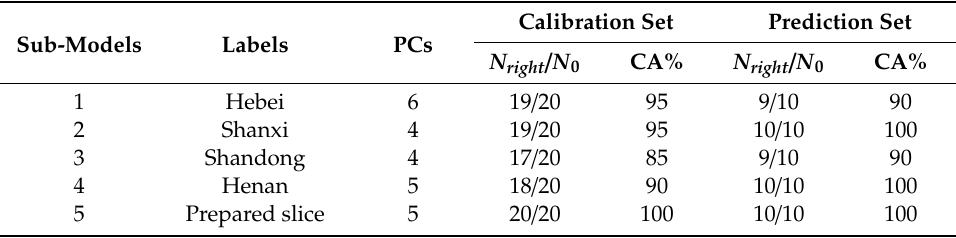
Figure 4. Root mean square error of cross-validation (RMSECV) values according to different number of PCs in sub-model 1. Table 1. Optimization and results of the soft independent modeling of class analogy (SIMCA) model of Trichosanthis Fructus samples .